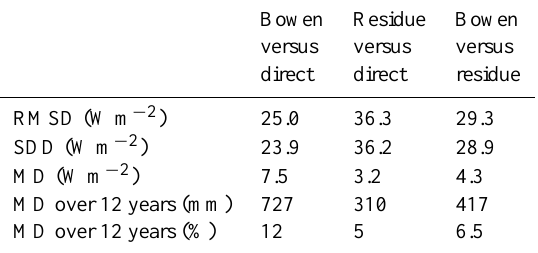
Table 7. Comparison of the direct measurement of LE (direct), the energy balance residue estimate of LE (residue) and the Bowen ra- tio estimate of LE (Bowen). RMSD is the root mean square of the differences between the LE estimates. SDD is the SD of the differ- ences between the LE estimates. For Y versus X , MD is computed as Y − X . In the last row, the MD in cumulative ET over 12 years is computed relatively to X . Bowen Residue Bowen versus versus versus direct direct residue RMSD (Wm − 2 ) 25.0 36.3